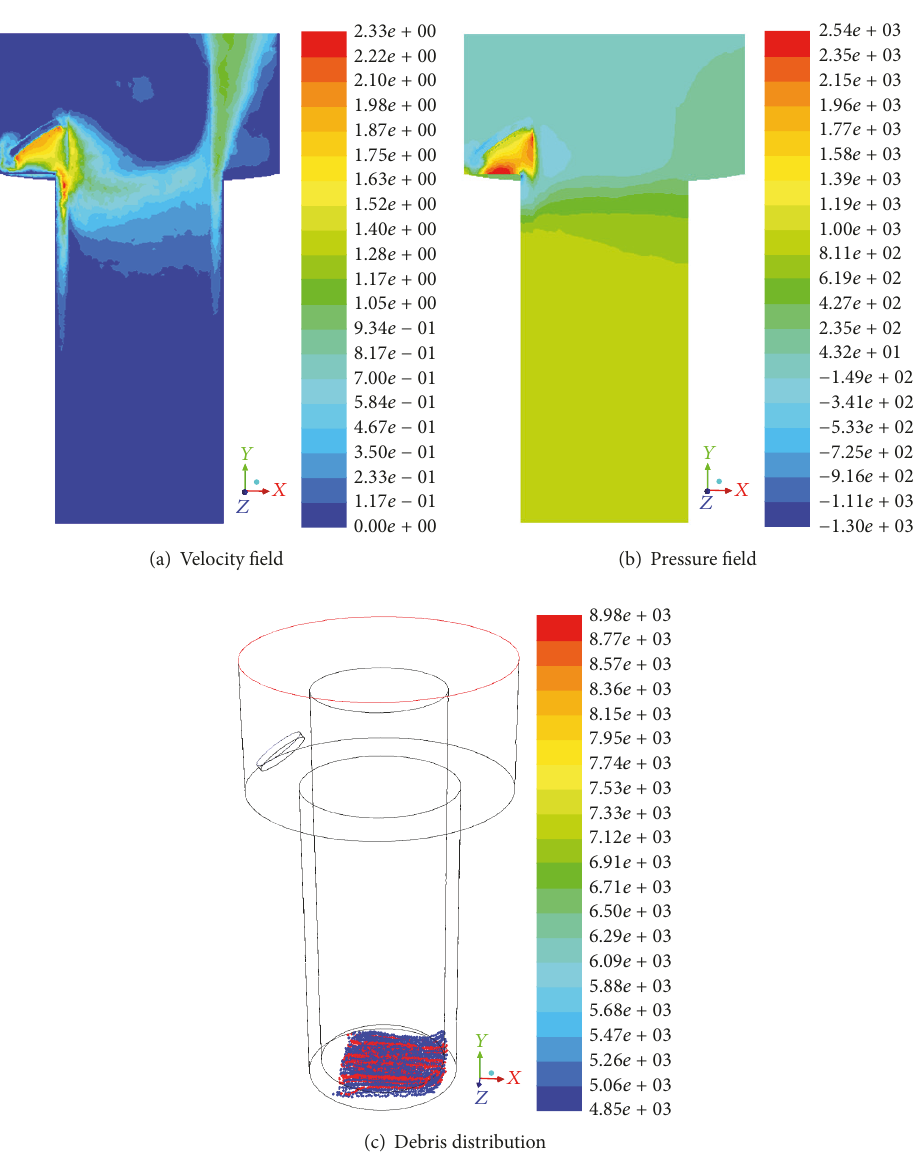
Figure 18: Schematics of gap flow field with flushing at 2m/s and 5 mm deep hole.